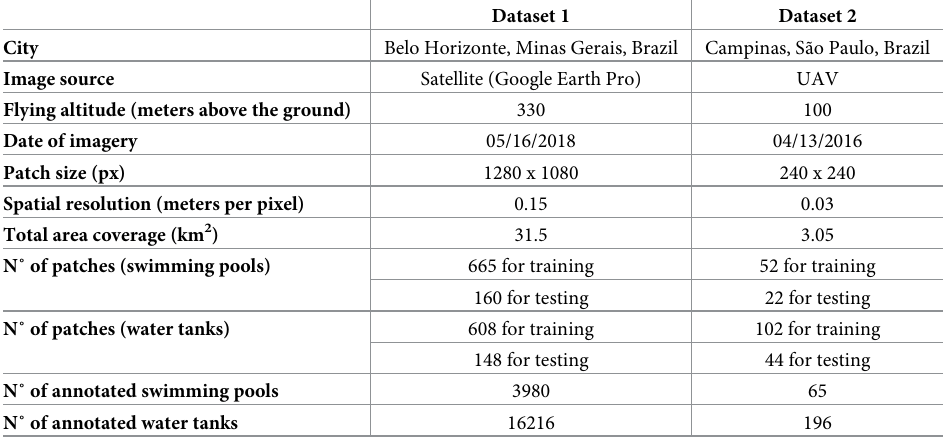
Table 1. Comparison between the Belo Horizonte and Campinas